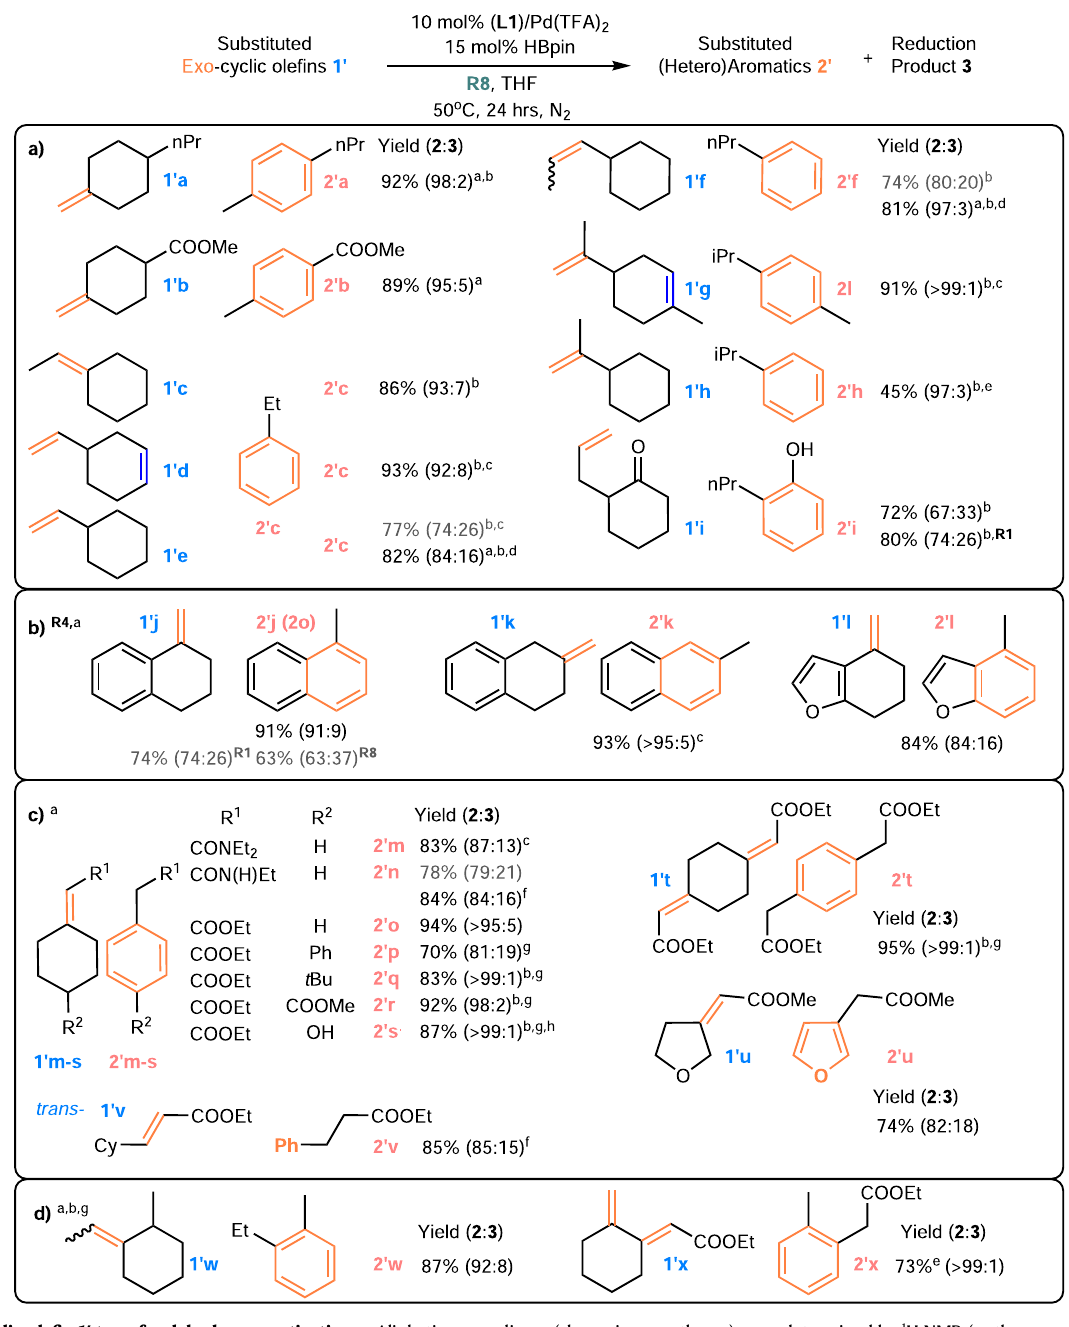
(shown in parentheses) were determined by 1 H NMR (as the average of two runs). a 48h; b as determined by GCMS (see the Supplementary Information for details); c 60°C; d 2.5 equiv. of R1 ; e Otherproducts are from ole fi n isomerization; f 3 equiv. of R8 ; g 70°C; h with a 9% aromatic product without